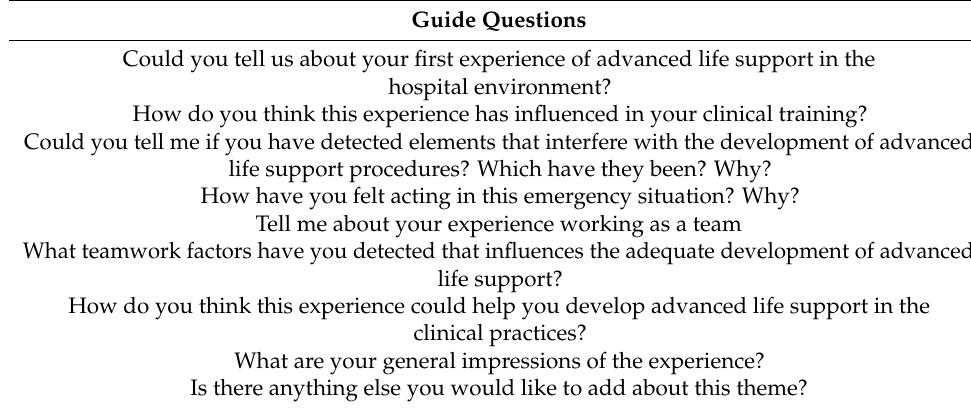
Table 1. Guide questions used for the focus